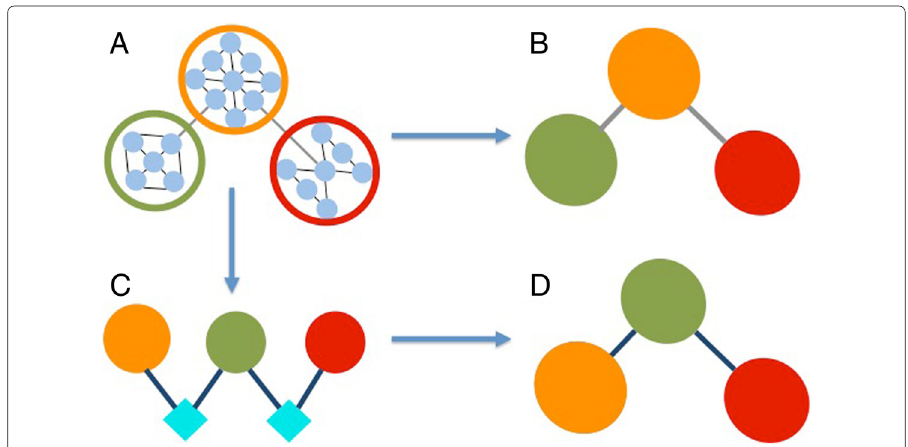
Fig. 1 Graphical description of the workflow presented here. a Module detection of tumor and control networks using infomap. In this figure, three modules are detected. b Modules detected in a become